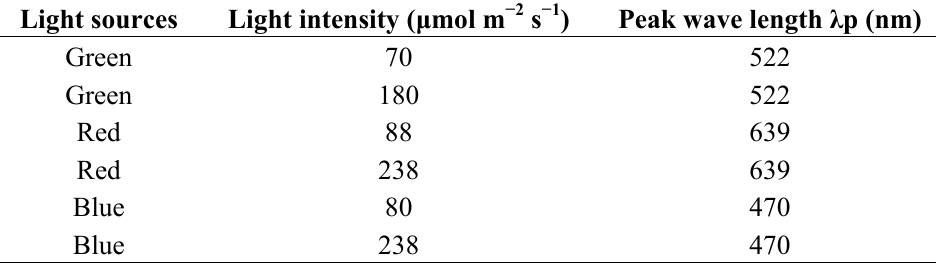
Table 2. Major light wavelengths of different light